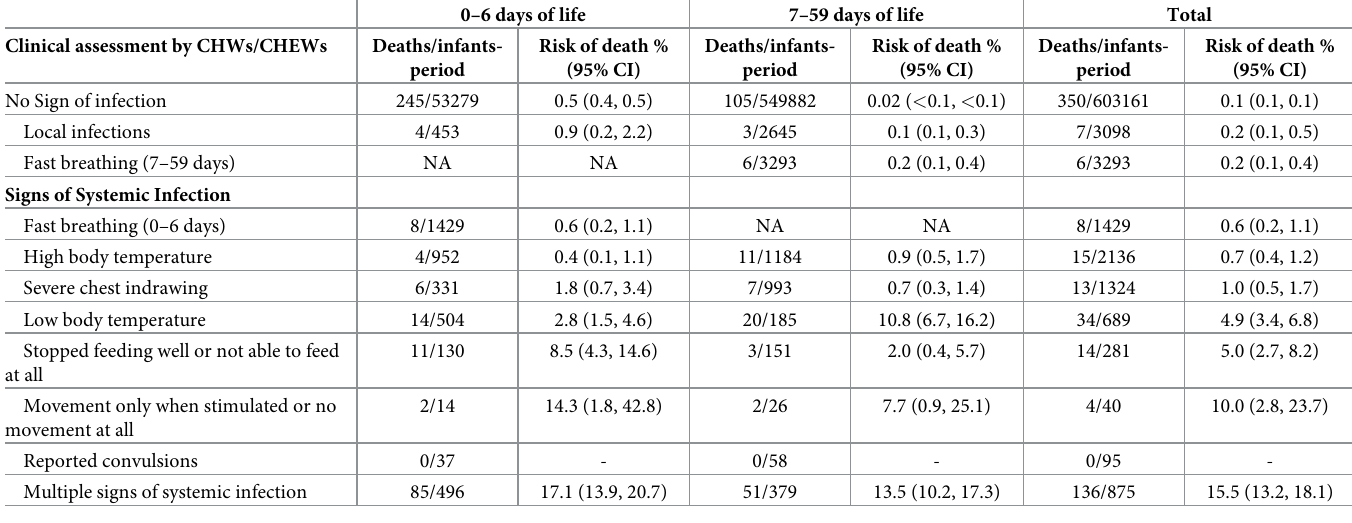
episode of either local or systemic infection when assessed by a CHW/CHEW at any visit dur- ing the first two months of life. Second, nearly half of the sick young infants identified at the community level had either fast breathing or local infections, followed by fever and chest indrawing that were seen more often than other signs such as stopped feeding well/not able to feed at all, low body temperature and multiple signs. CHWs didn’t find many young infants with movement only on stimulation/no movement at all or convulsions. Third, All signs of infection were frequently seen in the first week of life, but fever, low body temperature and multiple signs were most common in this age group. Fast breathing, chest indrawing, Table 2. Number of deaths by infant-periods of follow up and risk of death (%) by clinical signs stratified by 0–6 days and 7–59 days of